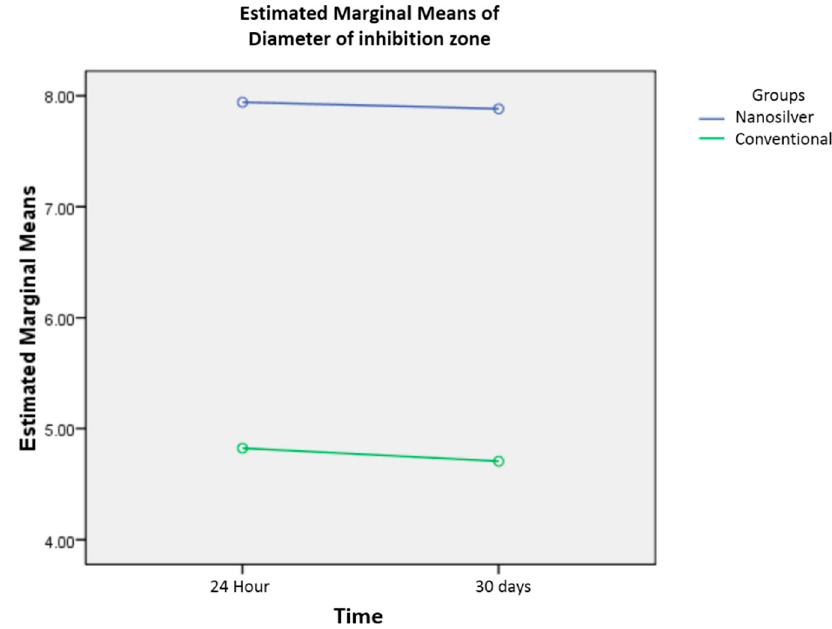
Figure 2. Inhibition zone diameter for conventional adhesive and nano-adhesive at 24 h and 30 days (mm). No interaction effect can be seen as there is a set of nearly parallel lines for both conventional adhesive and nano-adhesive.